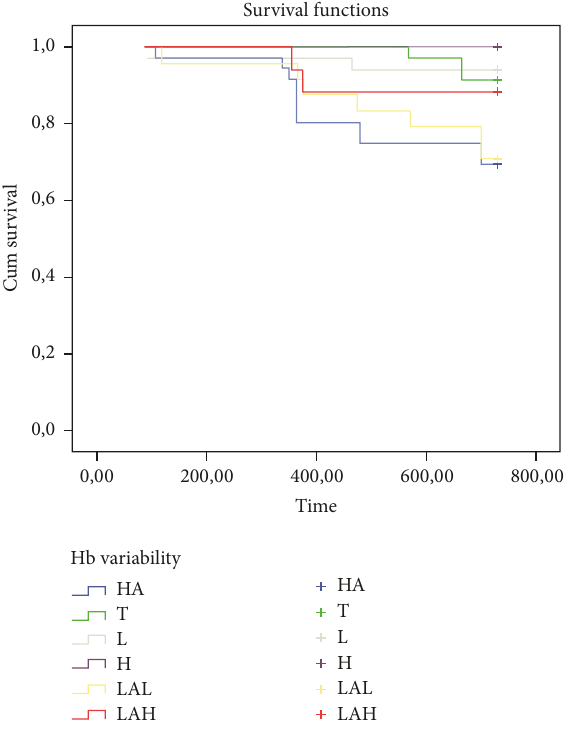
variability has a modest association with morbidity and all- cause mortality in erythropoietin-treated dialysis